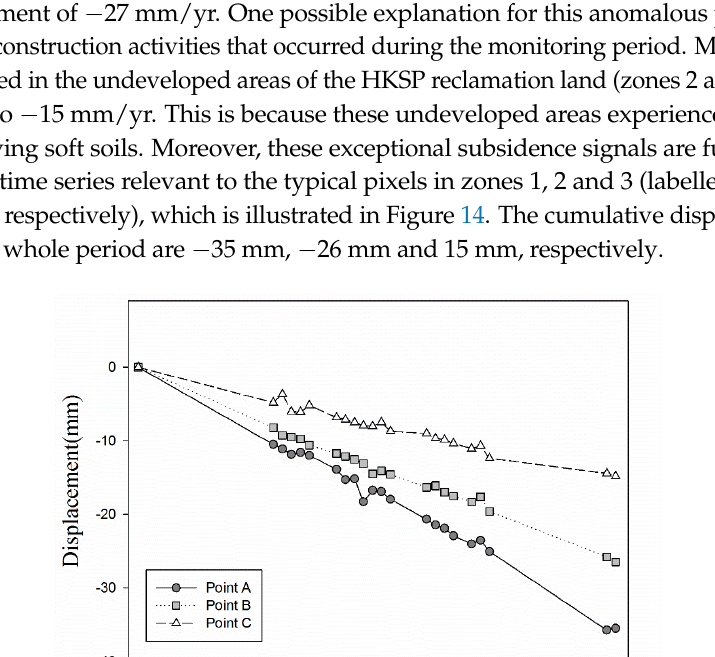
Figure 14. Displacement time series corresponding to the pixels labelled points A, B and C in Figure 13b.